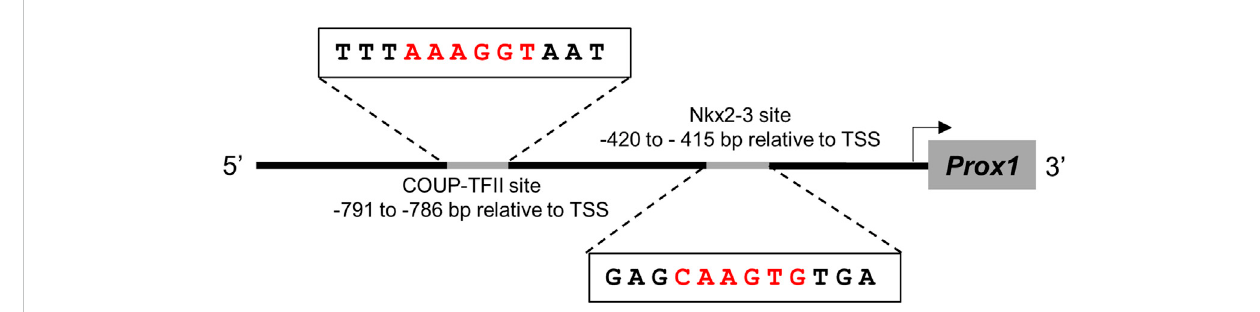
Sequence analysis of Prox1 promoter for putative binding sites for Nkx2-3 and COUP-TFII The transcription factors are indicated at the top, their binding sequence motifs are demonstrated according to JASPAR database, compared to the putative target sequences within the promoter and their sequence relative to transcription start site